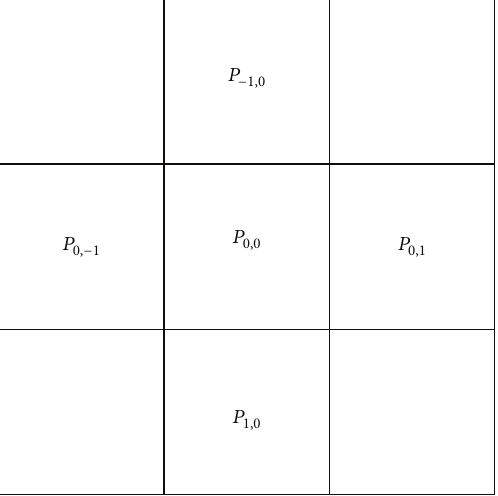
Figure 6: Transition